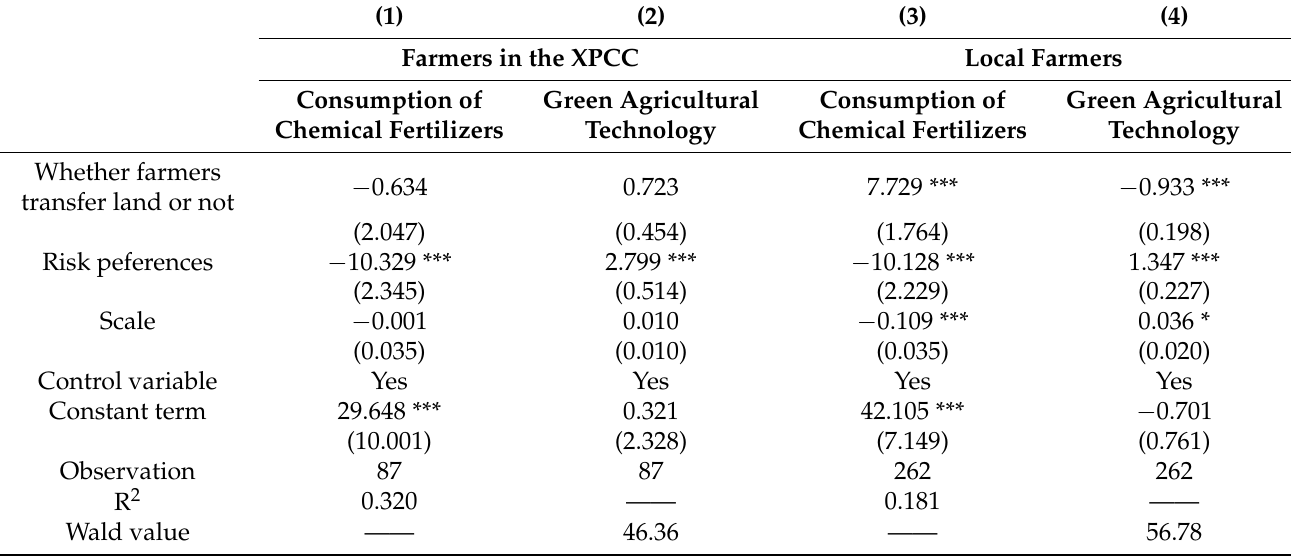
Table 5. Land transfer and household green production behavior: corps